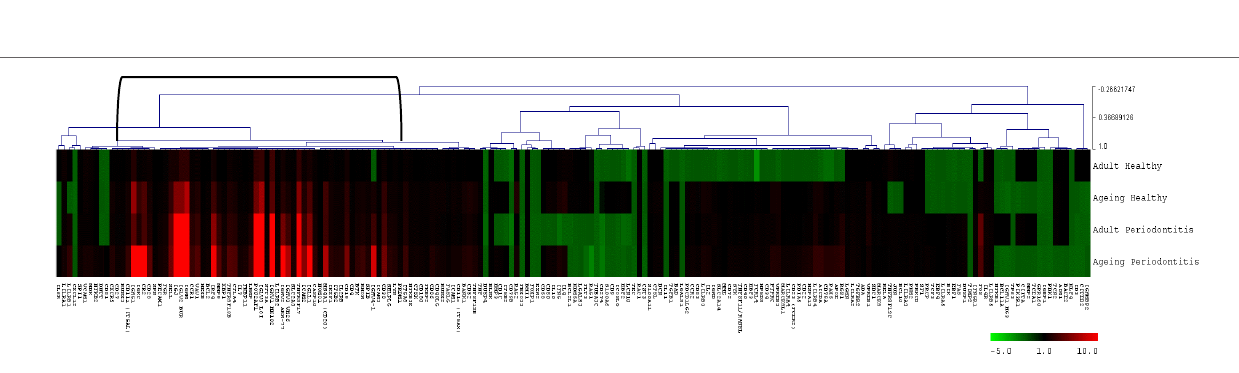
TaBle 3 | gene expression differences in adult and aged healthy and periodontitis tissues related to average gene response patterns in healthy tissue samples from animals 3–7 years of age (correlates with 11- to 25-year-old human). Fold difference gene iD adult h aged h adult PD aged PD Fxn. category a CCR1 1.2